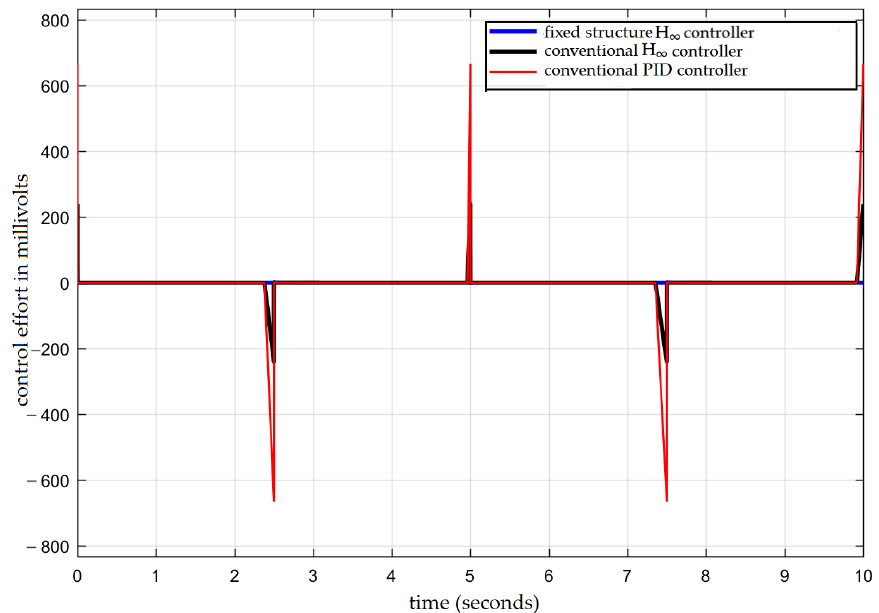
Figure 10. Control effort of all three controllers for angular position tracking (square input tracking as shown in Figure 9b).